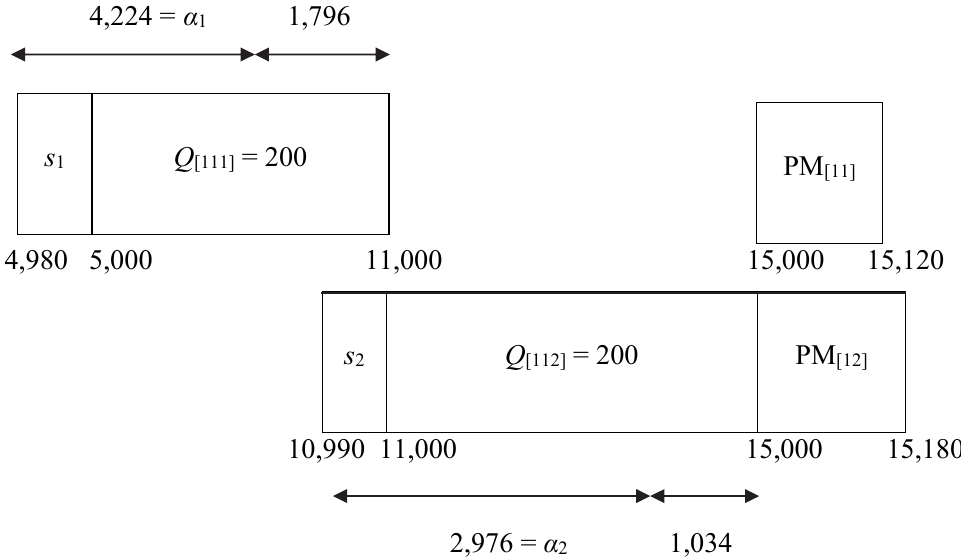
Fig. 2. Gantt-Chart for the first iteration with single batch for both of machines The best solution based on Algorithm [SITM] Number of batch